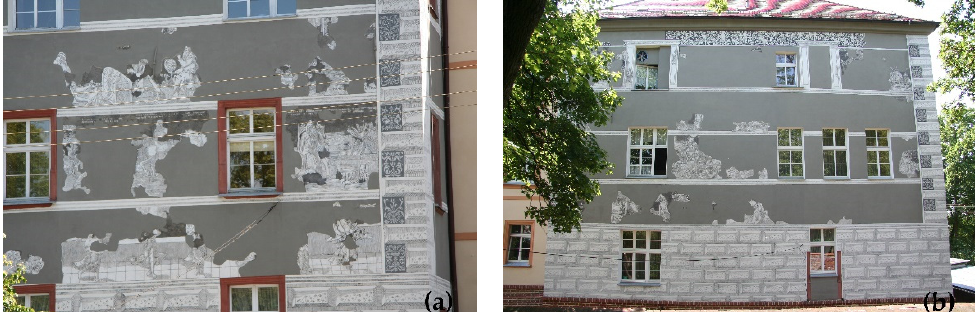
Figure 11. ( a ) Prószków castle: west elevation of north bastion, part with sgraffito, scene with mythological muses, upper king and person on a horse, photo by the authors. ( b ) Prószków castle: north elevation of north bastion, sgraffito decoration, photo by the authors.